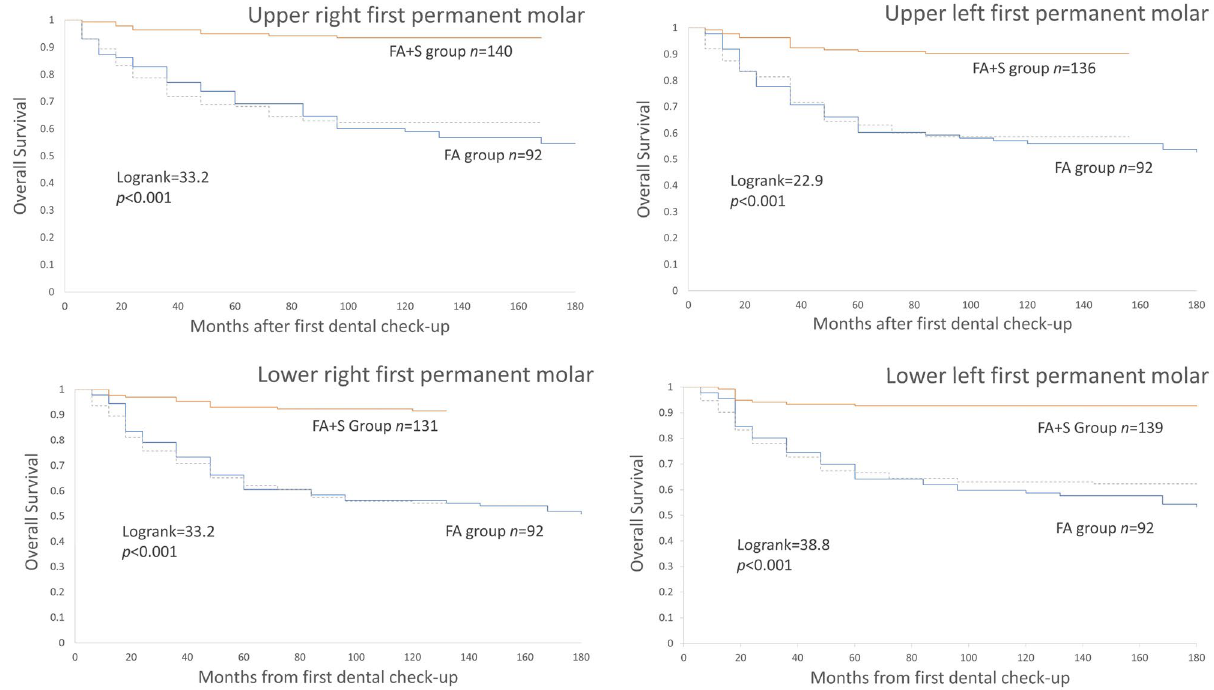
Figure 2. Kaplan–Meier survival curves illustrating the significance of fluoride varnish (FA group) and fluoride varnish together with fissure sealants (FA + S group) in the incidence of dental caries for each first permanent molar. Dotted lines represent Kaplan–Meier survival curves of fissure sealants for each